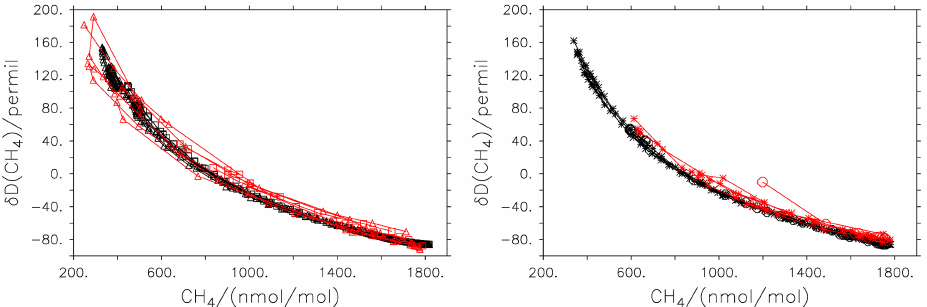
Figure 3. Comparison of the relations of δ D(CH 4 ) to CH 4 between EMAC (black) and balloon-borne data (red; data as in Fig. 2). The left panel shows the Arctic data (KIR, (cid:52) : vortex, (cid:3) : non-vortex) and the right panel shows the mid-latitude ( ∗ ) and tropical data ( ◦ ). The altitude range is 5 to